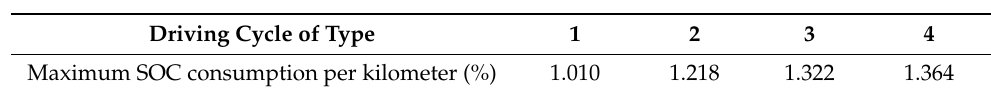
Table 2. SOC consumption per kilometer in EV